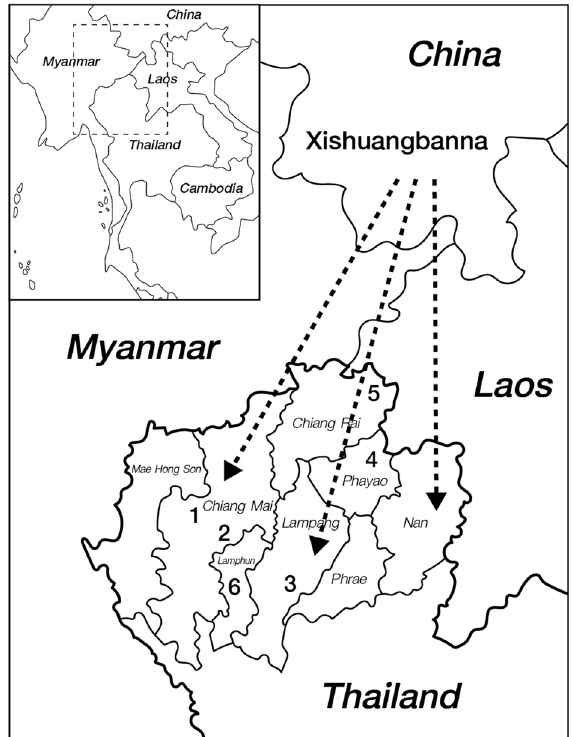
Figure 1. Schematic direction of the Lue’s migration from Southern China to Northern Thailand and the localities of studied villages. Drawing was adapted and used under license from Shutterstock.com. Original drawings can be found at https ://www.shutt ersto ck.com/image -vecto r/south east-asia-map-56575 4383, https :// www.shutt ersto ck.com/image -vecto r/high-quali ty-map-north ern-regio n-thail and-16641 40510